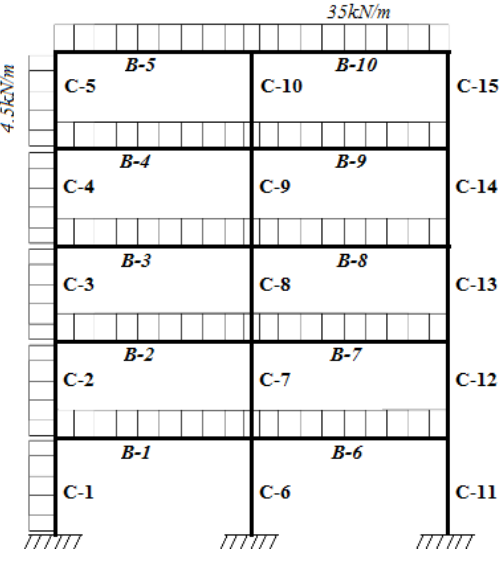
Figure 6. The 2-D frame and loading example